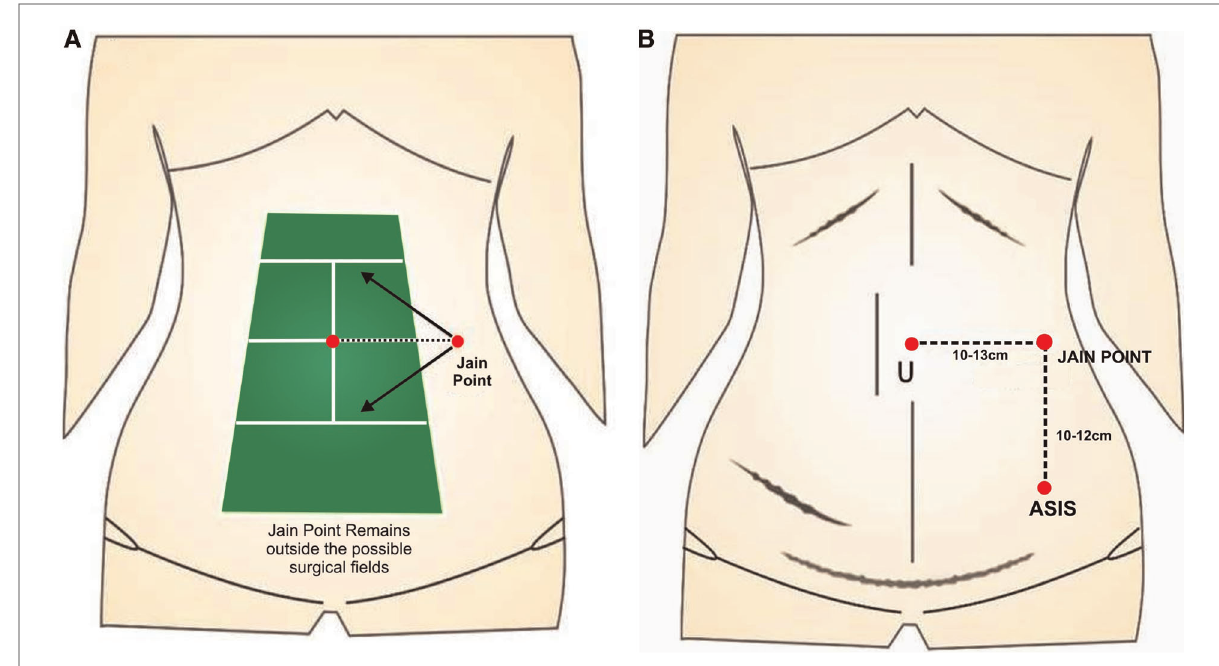
FIGURE 2 ( A ) Concept of a Jain point; it mimics the position of a referee on a tennis court who is sitting outside the surgical fi eld. ( B ) Jain point is equally applicable for the upper-, mid-, and lower-abdomen